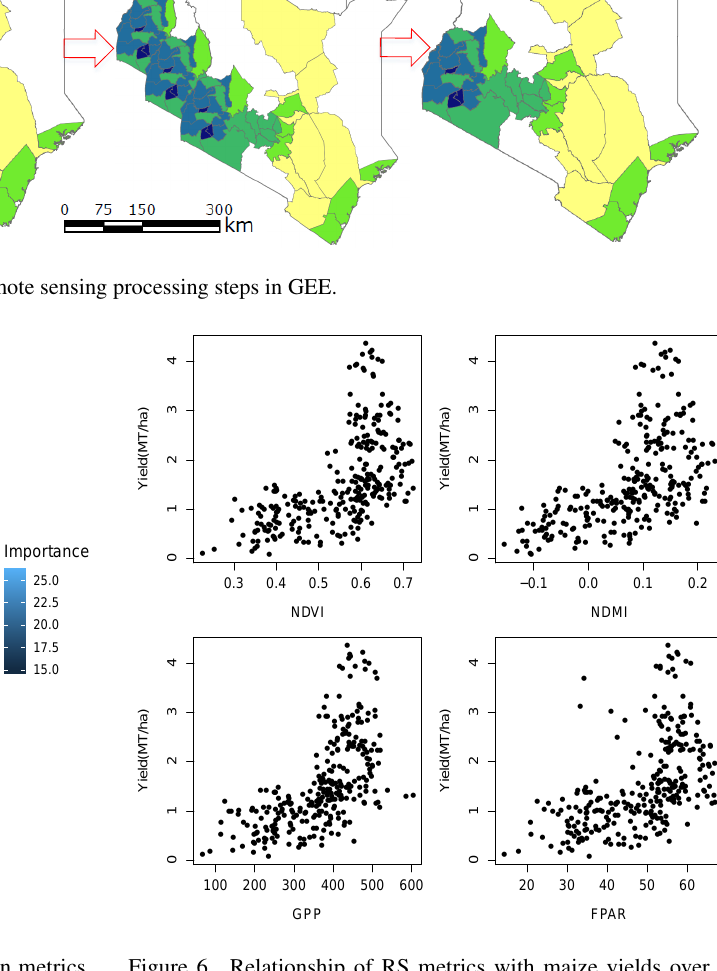
Figure 5. Selection of remote sensing yield prediction metrics using RF.